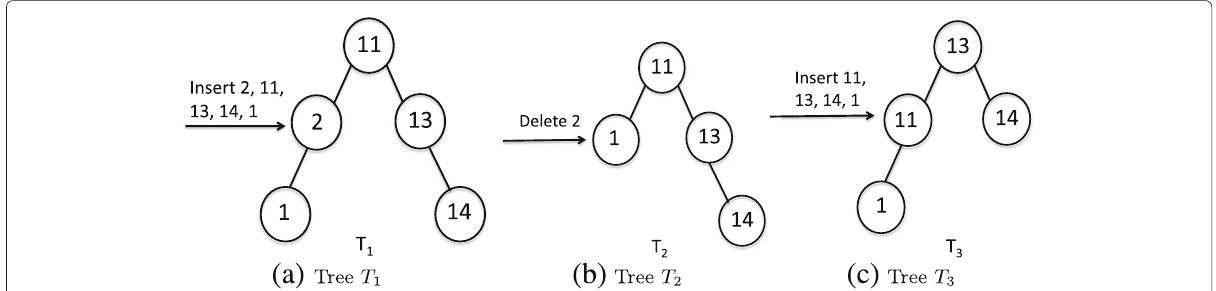
Fig. 3 An example from (Chen et al. 2016) showing why structural artifacts matter. T 1 , T 2 , and T 3 are balanced BSTs. a Tree T 1 , b Tree T 2 , and c Tree T